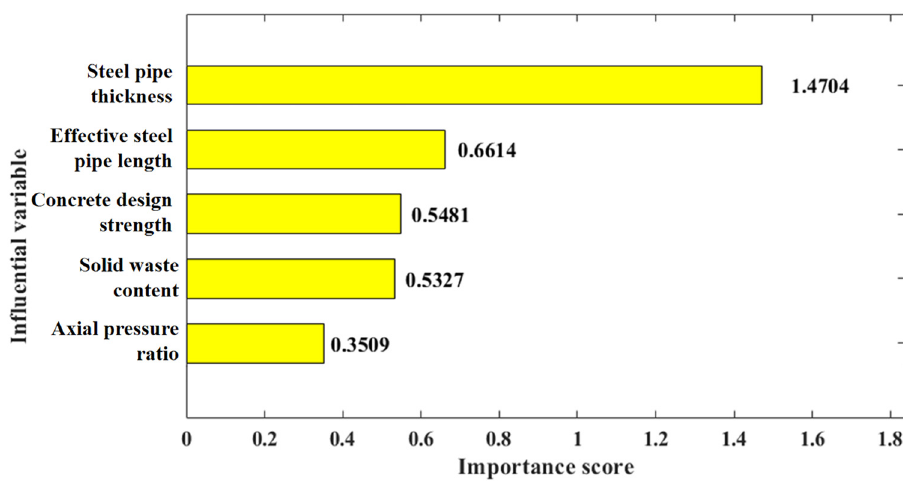
Figure 22: Variable importance analysis of FA – RF model for equivalent damping coe ffi cient